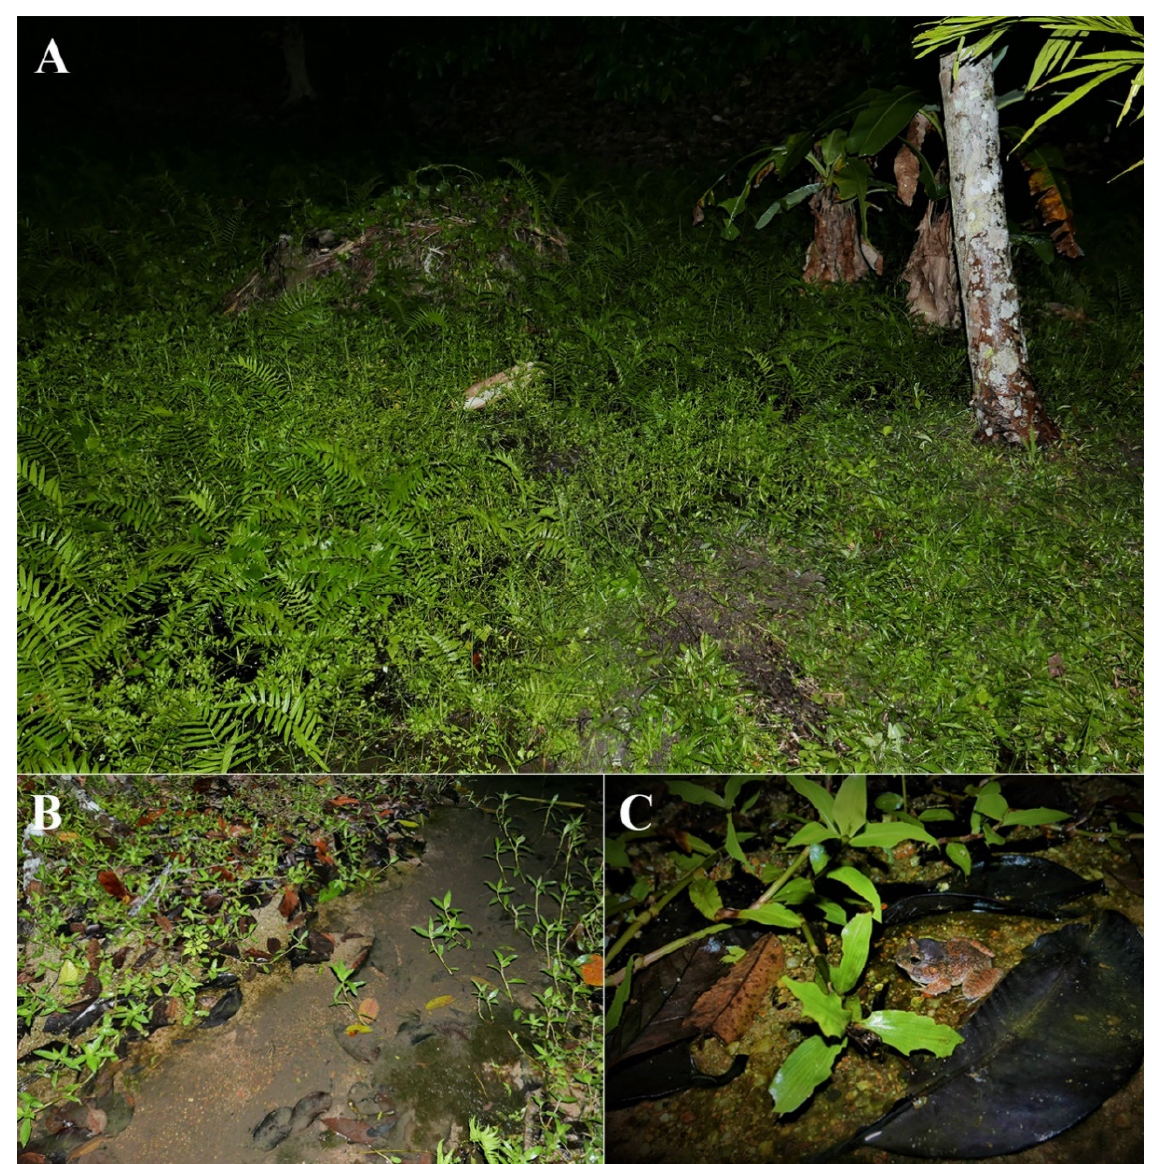
Figure 10. Habitat of calling males of Limnonectes pseudodoriae sp. nov . ( A , B ) An orchard near the forest edge in Ko Pha-ngan Island, Surat Thani Province, and ( C ) an adult male in shallow water, presumably where they were heard calling. At Ko Lanta Yai Island, L. pseudodoriae sp. nov . was taken on the forest floor covered with grasses and leaf litter, or on a gravel and sand bank, near a small, shallow, flowing stream (ca. 1 m wide) near Thum Khao Mai Kaew Cave on 3 May 2016 and 11 July 2017 (Figure 9C). No calling males were observed. Other sympatric frog species found at this locality included D. melanostictus (Schneider, 1799), F. limnocharis (Gravenhorst,